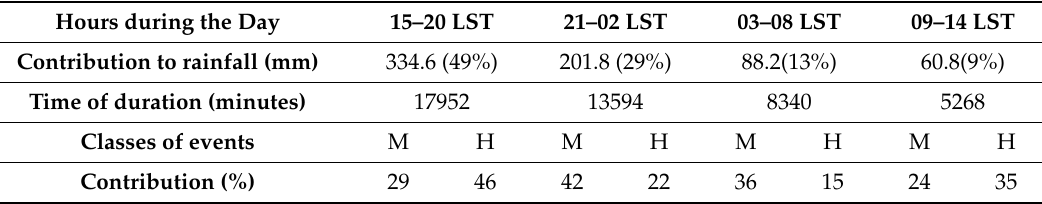
Table 2. Diurnal cycle of the contributions of one-minute rainfall samples to total rainfall registered by Parsivel2. In 6-h intervals, including all the one-minute measurements (November–April, in total 12 months of the 2017–2019 period) of the heavy and moderate rain. The parentheses indicate contribution in percentages. H: heavy events M: moderate events.